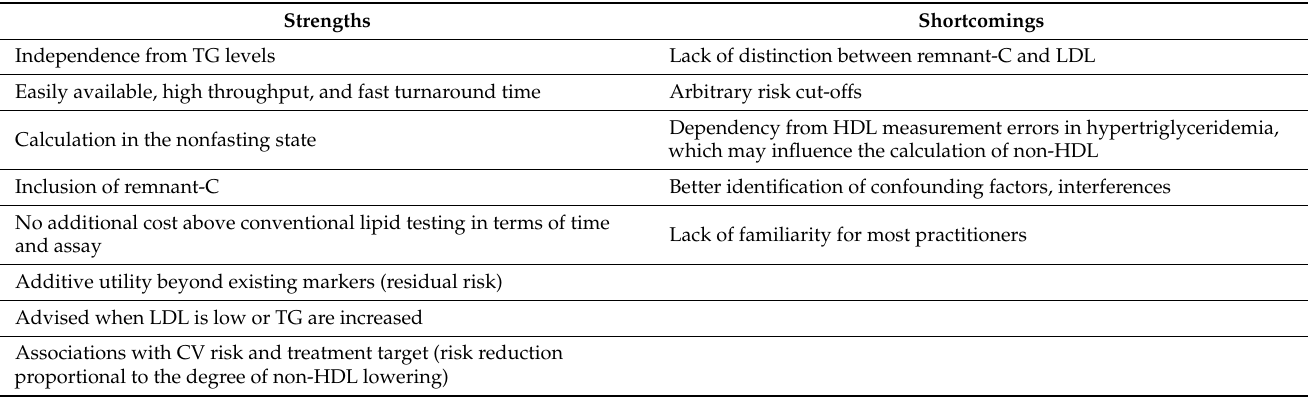
Table 3. Specific strengths and aspects to improve in the use of non-HDL for evaluation of CV risk estimation in